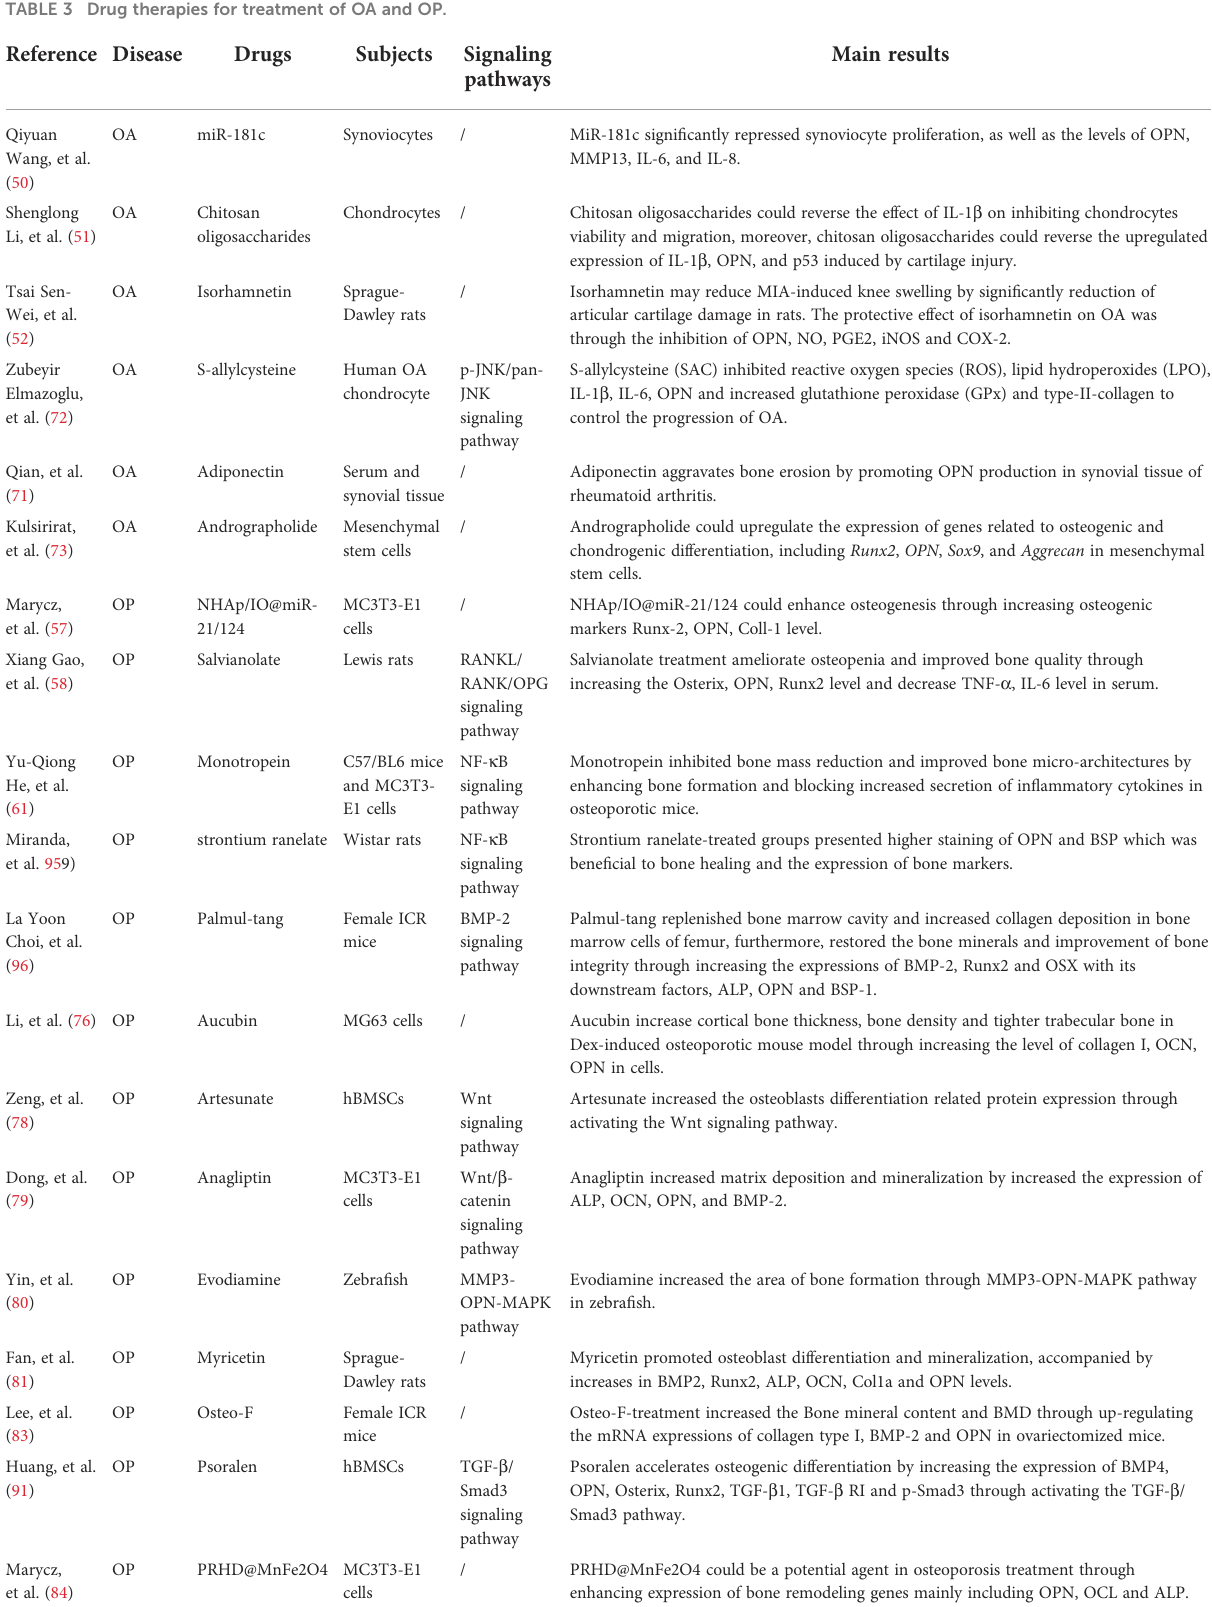
TABLE 3 Drug therapies for treatment of OA and OP. Reference